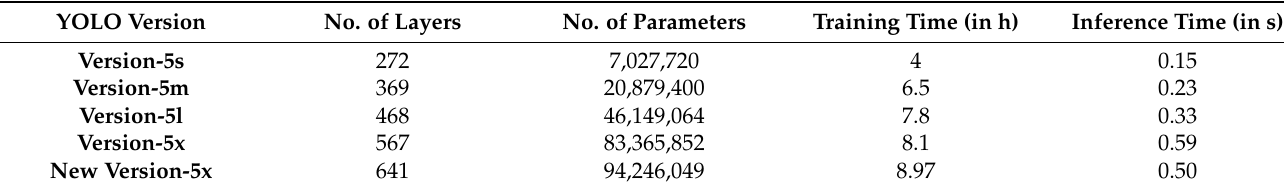
Table 2. Various versions of YOLOv5 models used in the